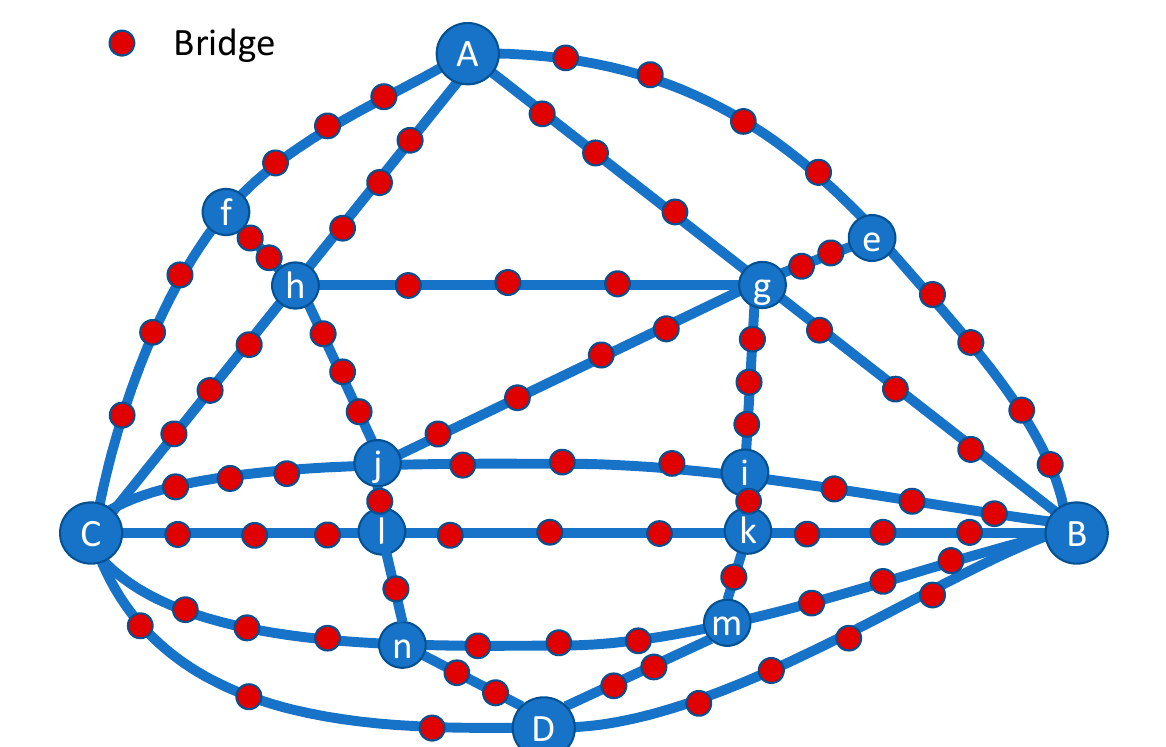
Figure 2. Layout of the highway road network, with indication of bridge positions.